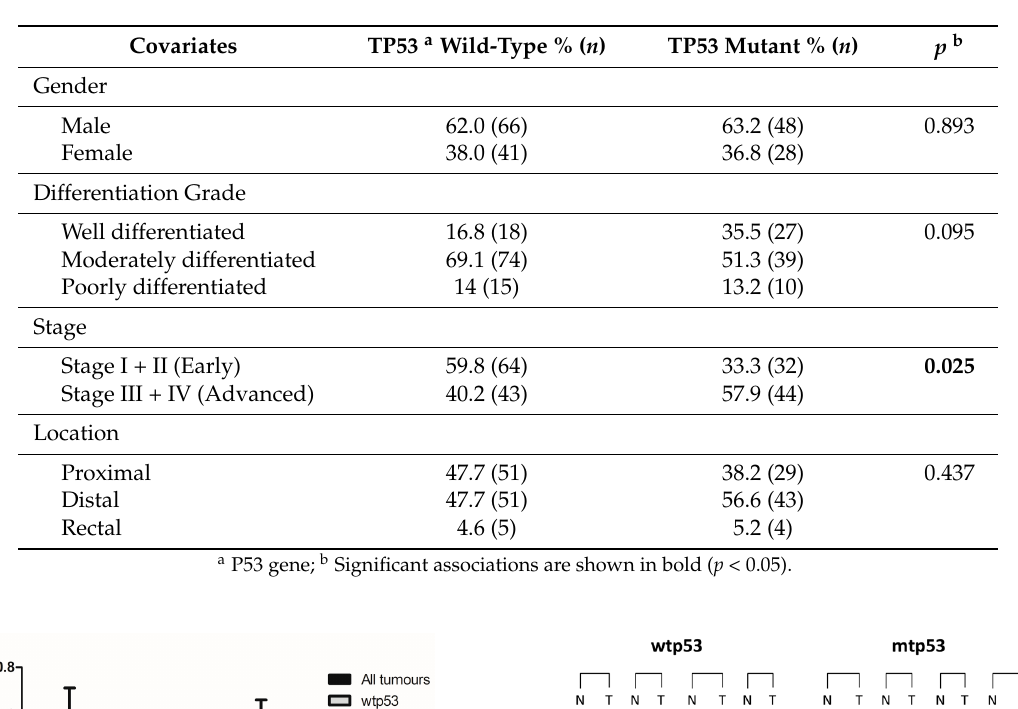
Table 1. Prognostic covariates.